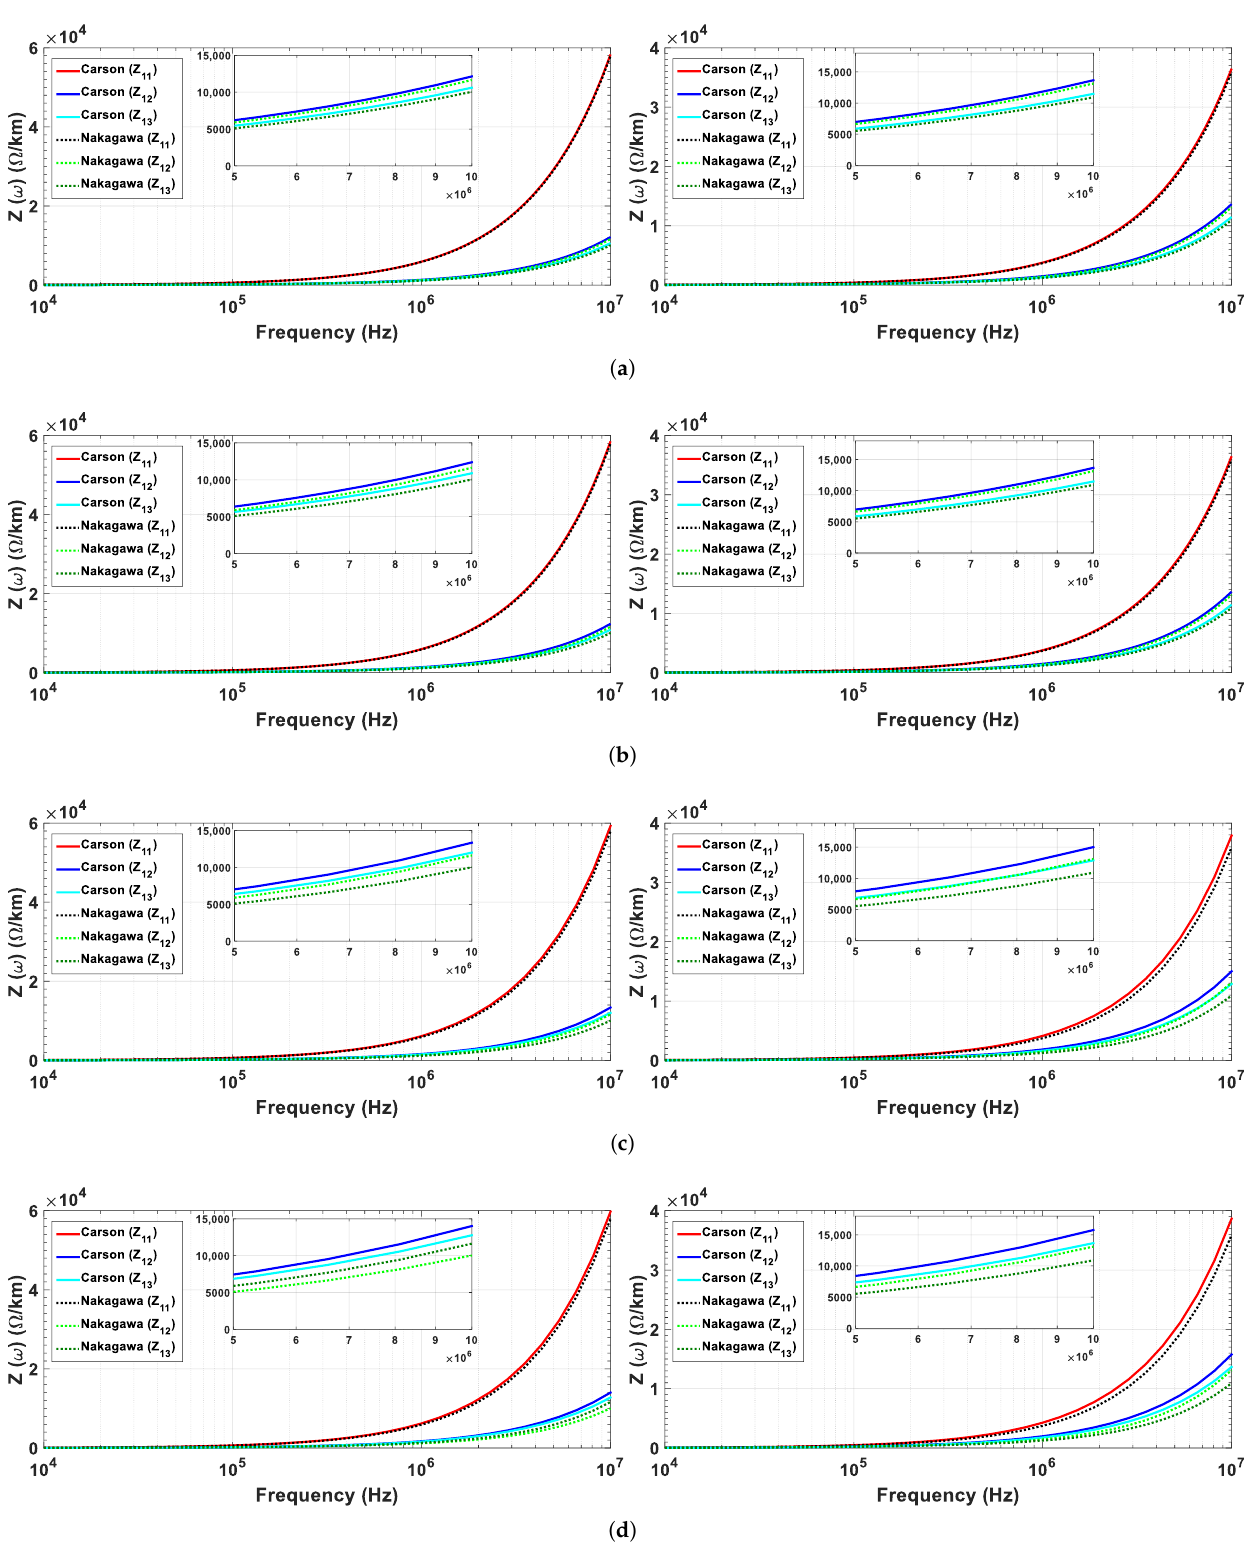
Figure 7. Longitudinal impedance (only elements Z 11 , Z 12 and Z 13 ) computed for the single-circuit TL of Figure 6a (left) and double-circuit TL of Figure 6b (right) located on soils with ρ 0 equal to: ( a ) 500 Ω · m; ( b ) 1000 Ω · m; ( c ) 5000 Ω · m and ( d ) 10,000 Ω ·